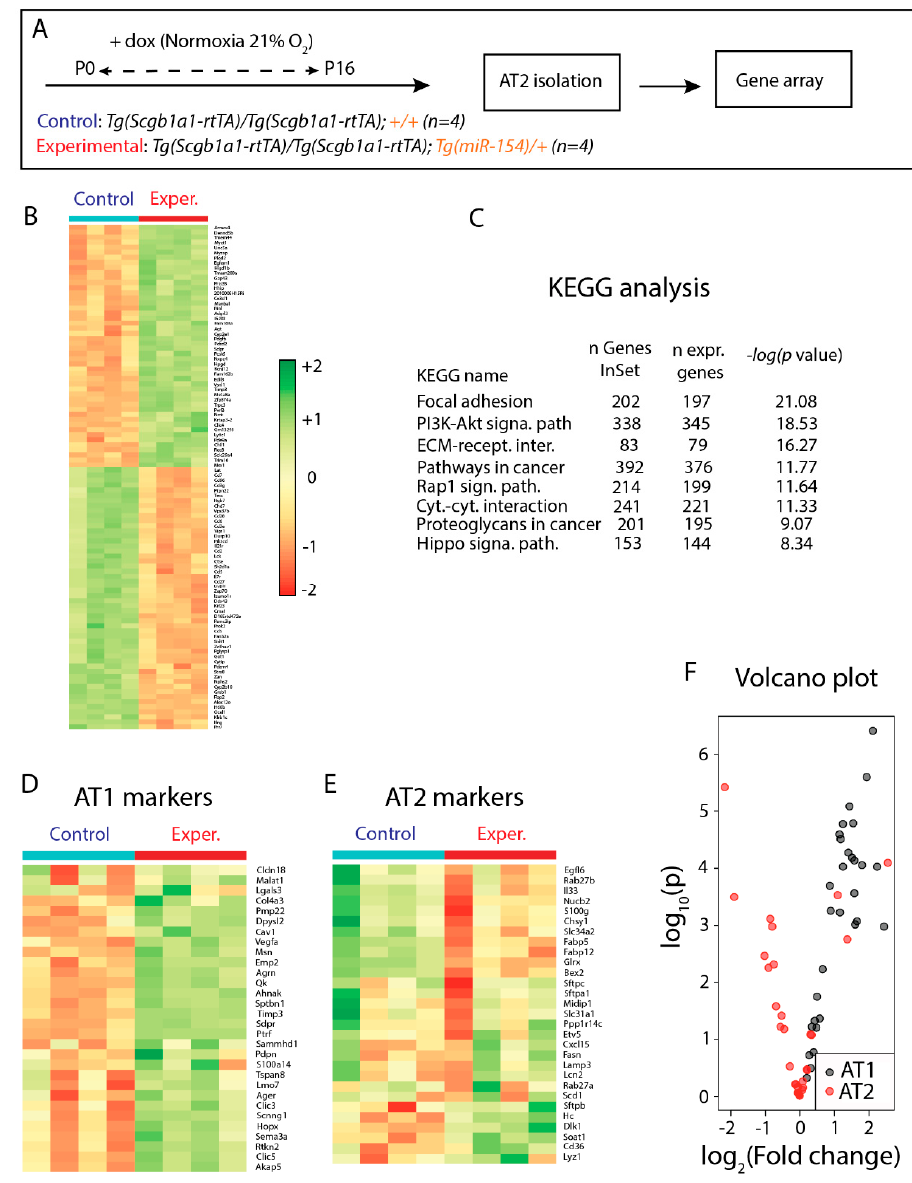
Figure 4. Gene Array Analysis performed on isolated AT2 samples: A . Model of miR-154 induction by doxycycline administration. B . Di ff erentially expressed genes upon miRNA overexpression. C . KEGG Analysis. D . Di ff erential regulation of AT1 markers. AT1 markers appear to be increased in expression levels upon miR-154 overexpression (Exper.) compared to control. E . Di ff erential regulation of AT2 markers. AT2 markers appear to be inconsistently altered in expression levels upon miR-154 overexpression (Exper.) compared to control. F . Volcano plot demonstrating the increased AT1 signature in isolated AT2 cells after miRNA induction compared to Control. For control and experimental n =